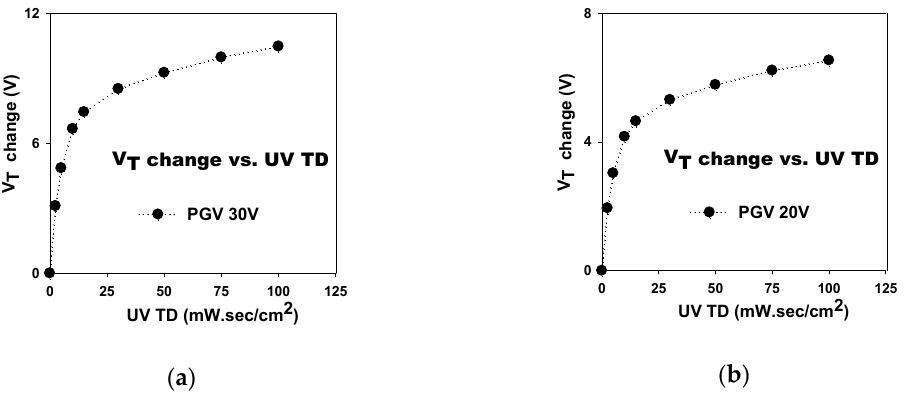
Figure 4. The dependence of the UV-induced V T increase on UV TD for an SAHAOS-T3 capacitor ( a ) at PGV 30V; ( b ) at PGV 20V.